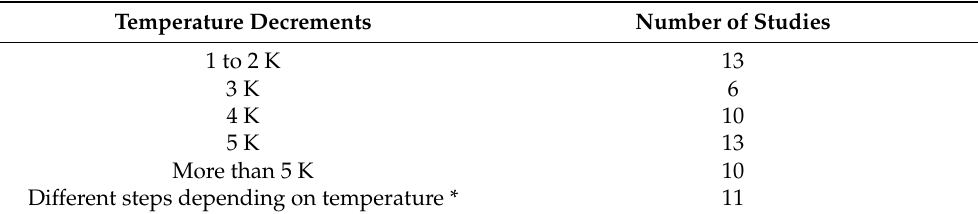
Figure 9. Number of studies according to the number of test temperatures used in each study. Temperature decrements were defined as the smallest distance between two adjacent test temperatures used in a study. Temperature decrements of 1–2 K were quite frequently used in 20.6% of studies for which temperature steps could be calculated (Table 5). This value fell within the range of accuracy of reached temperatures (the difference between temperatures programmed and actual temperatures achieved), which was between 0.1 and 2.0 K for the studies where it was measured (Table 6). Table 5. Number of studies according to temperature decrements (difference between two adjacent test temperatures) used in the studies. Table only includes those studies where the temperature decrements were given or could be calculated.